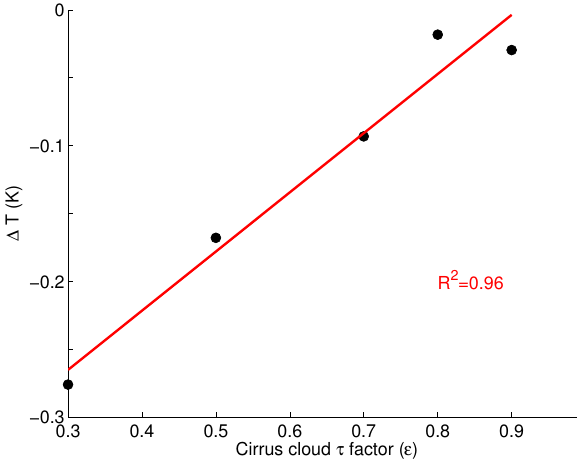
Figure 4. A sensitivity study of the effects of changing cirrus ice crystal sedimentation velocity in NorESM1-ME. vfx2, vfx4, and vfx8 indicate an increase in the sedimentation velocity by 2, 4, and 8 times, respectively. y axis shows the global mean tempera- ture change as a function of year ( x axis); differences are calculated with respect to an average over years 2050–2055 under an RCP8.5